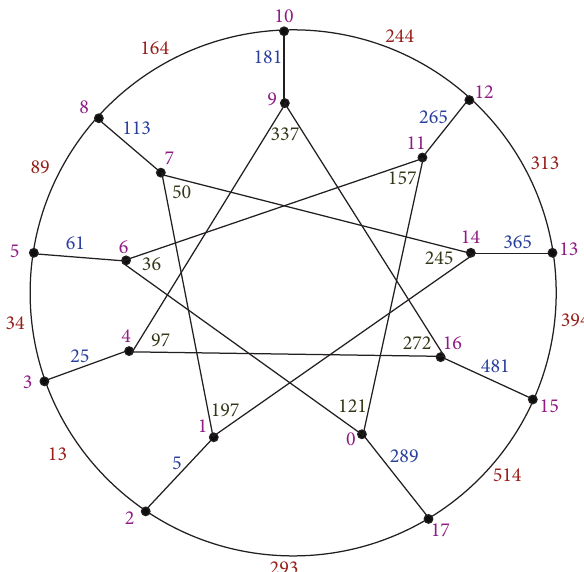
Figure 2: Square sum labeling of Petersen graph P [9,3].